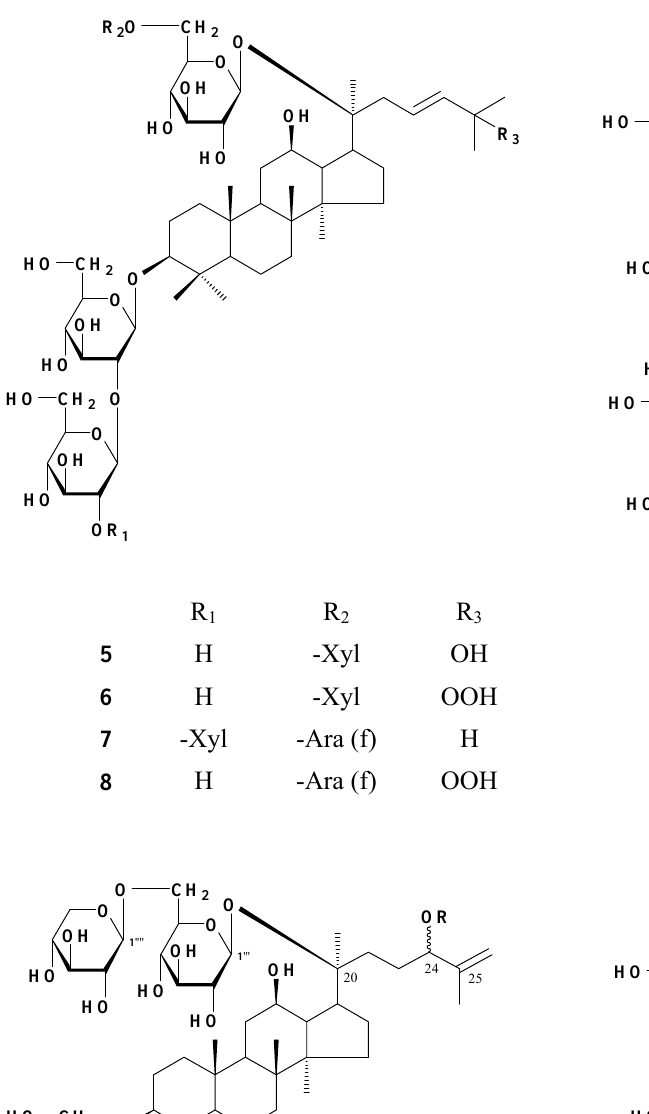
Figure 1. Structures of compounds